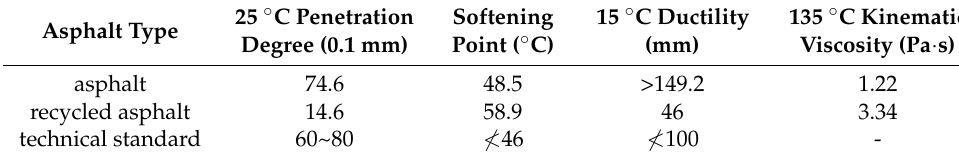
Table 2. Test conclusion of recycled asphalt performance.